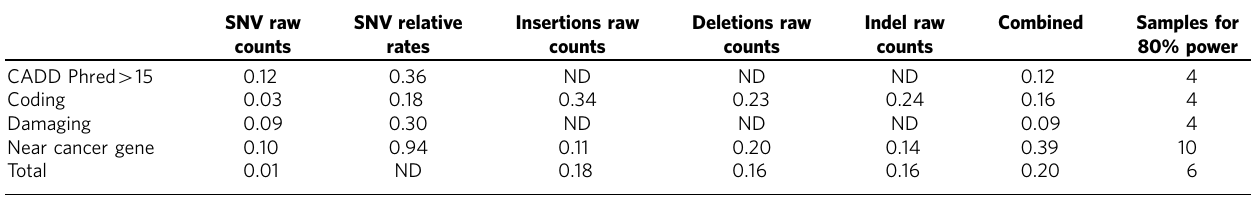
Table 1 | P values from the permutation-based ANOVA test for variant-type differences across the three reprogramming